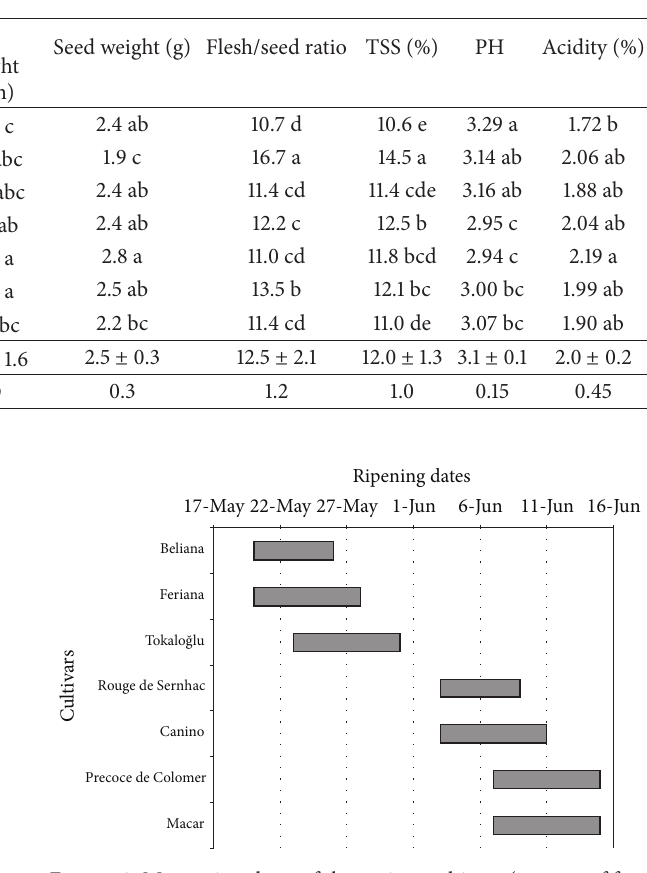
Figure 1: Meteorological data for D¨ortyol, Hatay, in the eastern Mediterranean region of Turkey. (a) Minimum ( Δ ), maximum (O), and average temperatures ( ◻ ) and (b) rainfall level (grey columns) and mean humidity (O) in growing years. Table 1: Some fruit quality characteristics of the apricot cultivars (average of four years).